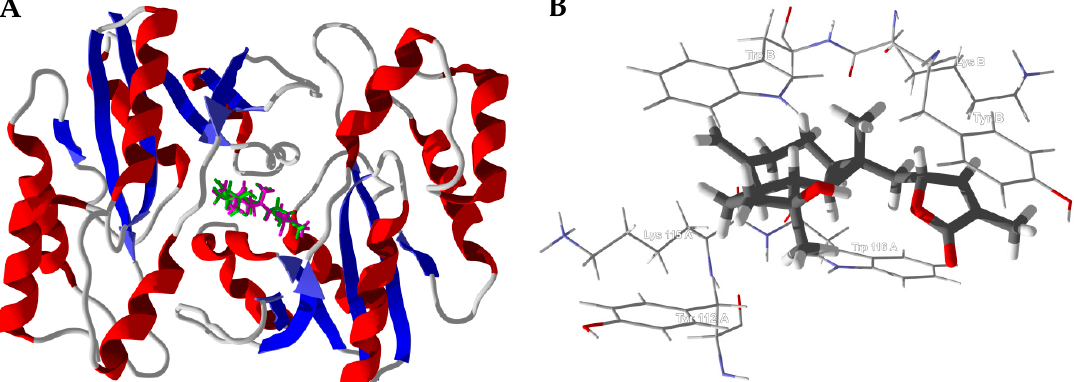
Figure 8. Bacillus anthracis nucleotide adenylyltransferase (BaNadD, PDB 3hfj). ( A ): Lowest-energy docked poses of boscartol E (magenta) and boscartol I (green) in the active site of the dimeric enzyme. ( B ): Boscartol I in the hydrophobic pocket formed at the interface of the two protein monomers. Human folate receptor β (HsFR β ) is overexpressed in activated macrophages associated with